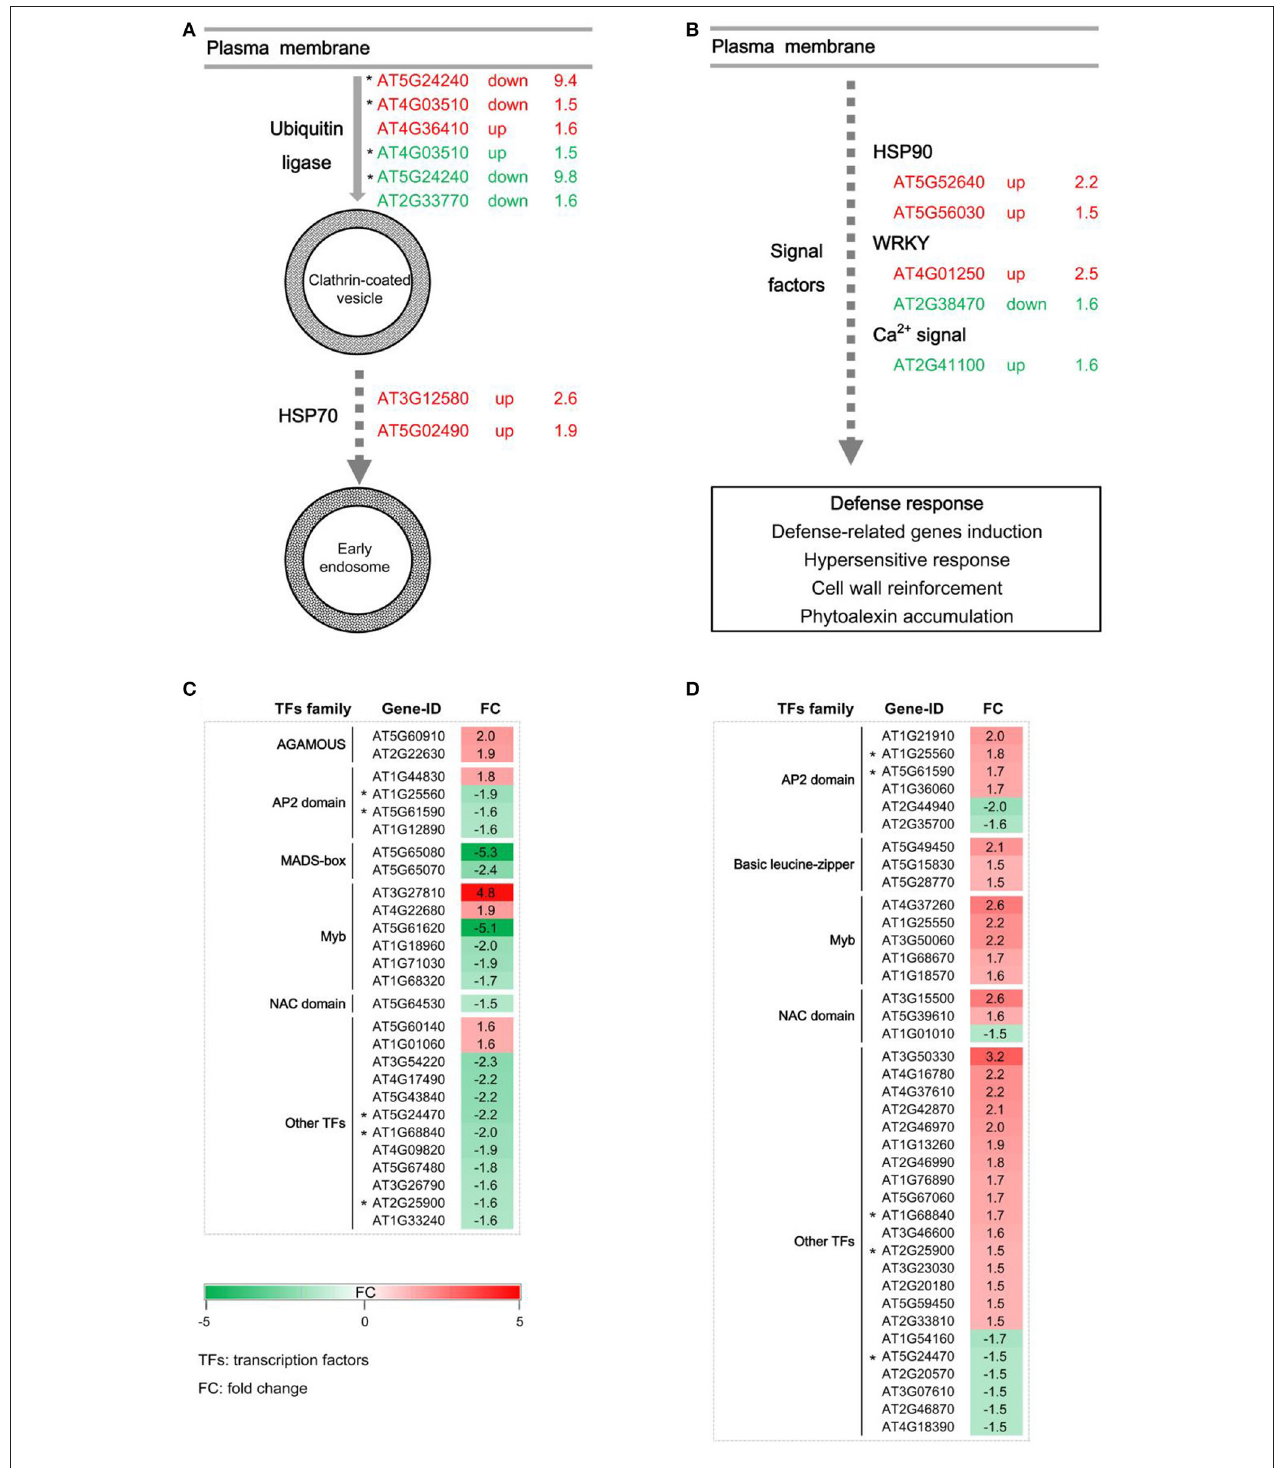
FIGURE 6 | Pathway enrichment analysis of differentially expressed genes in GbaVd1 and GbaVd2 transgenic plants. (A) Differentially expressed genes involved in the endocytosis process. The differentially expressed genes associated with the GbaVd1 and GbaVd2 transgenic plants are shown in red and green, respectively. (B) Differentially expressed genes involved in signal transduction. (C,D) Activation of genes encoding transcription factors after GbaVd1 (C) or GbaVd2 (D) overexpression in Arabidopsis . The red and green blocks represent the up- and down-regulated patterns, respectively, and genes with asterisks represent the common activation genes between the GbaVd1 and GbaVd2 transgenic